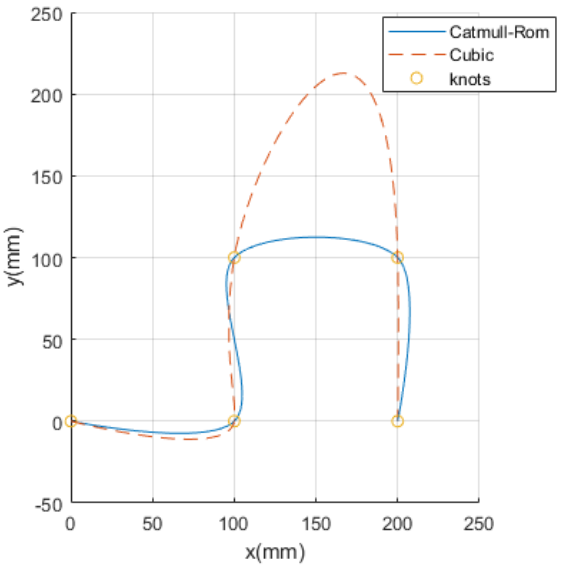
Figure 11. Path for five knots in the task #1 when two different methods are applied.